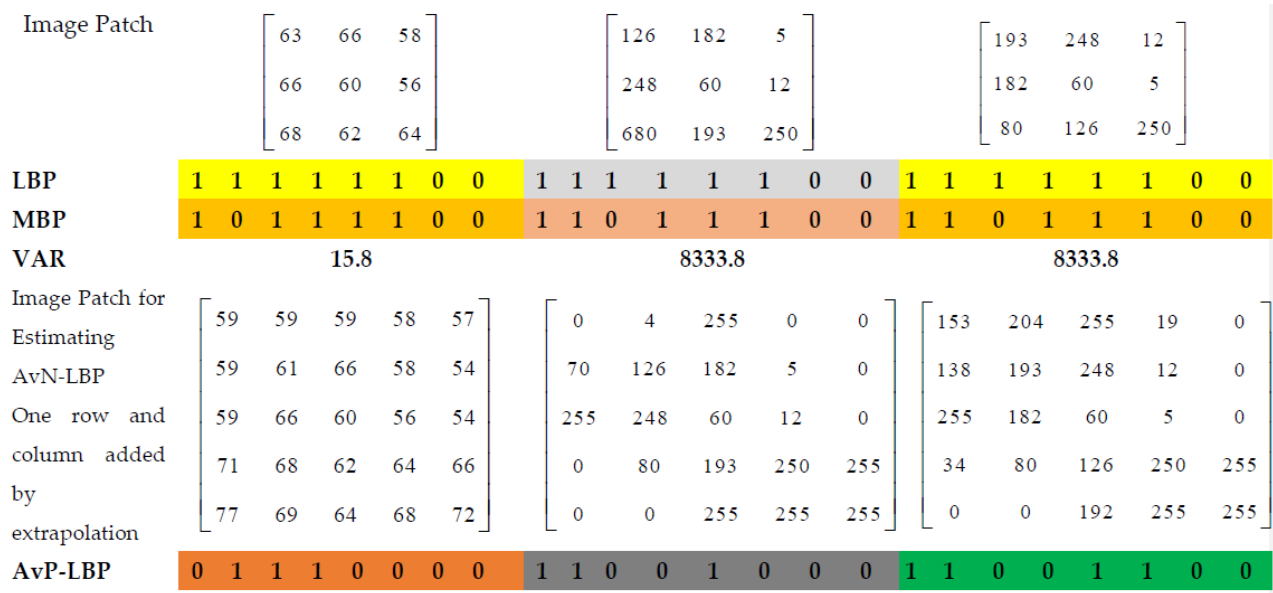
Figure 4. Three texture patterns and LBPs, AvN-LBPs. MBPs, and VAR values for the texture patterns.